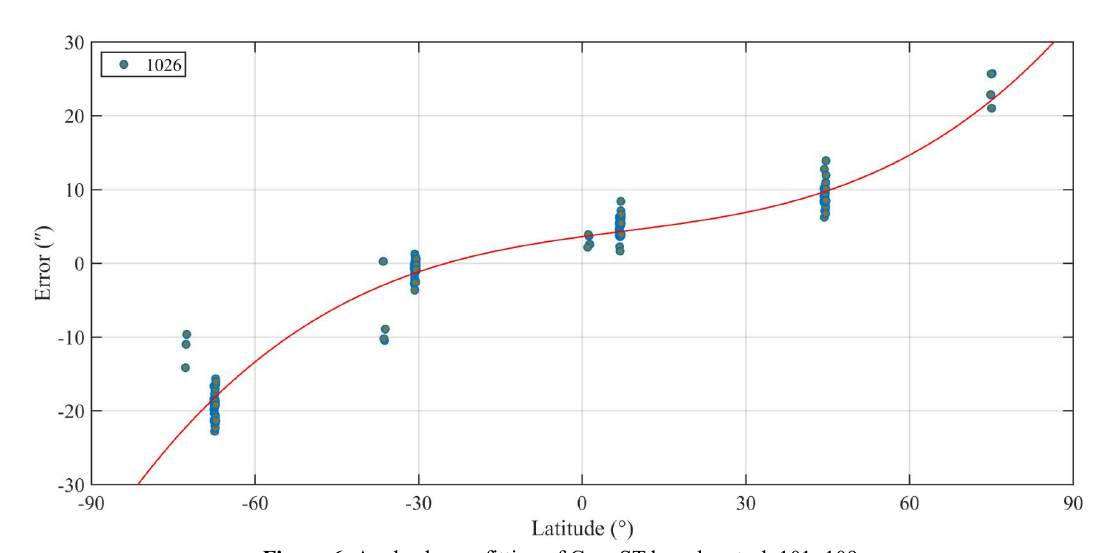
Figure 6 . Angle change fitting of Cam-ST based on task 101~109.